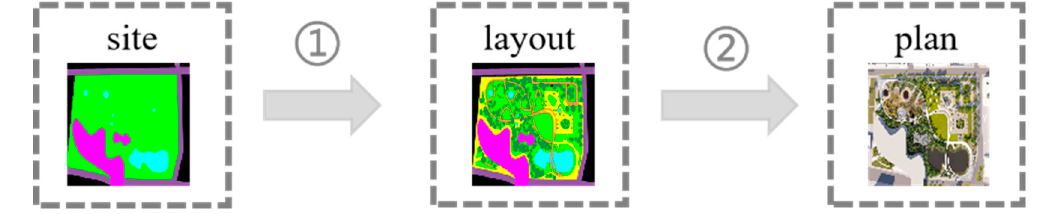
Figure 1. The procedure of the automatic generation approach.